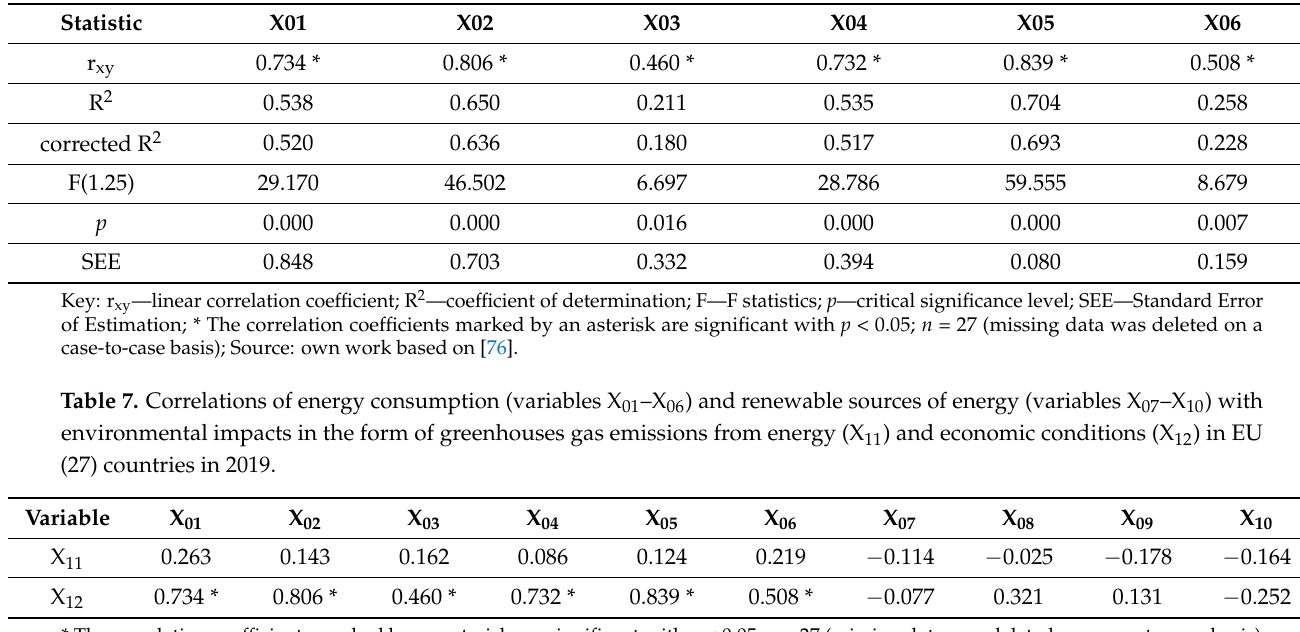
Table 6. Summary of multiple regression between variable X 12 (GDP per capita) and variables X 01 –X 06 describing primary and final energy consumption in total and by individual sectors—analysis of the impact of economic conditions on energy consumption in EU (27) countries in 2019.